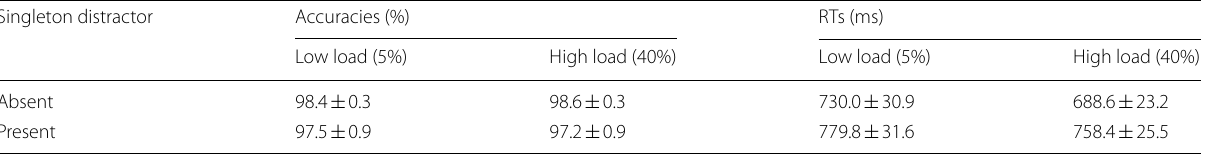
Table 1 Mean accuracies and correct reaction times (RTs) from each experimental condition Singleton